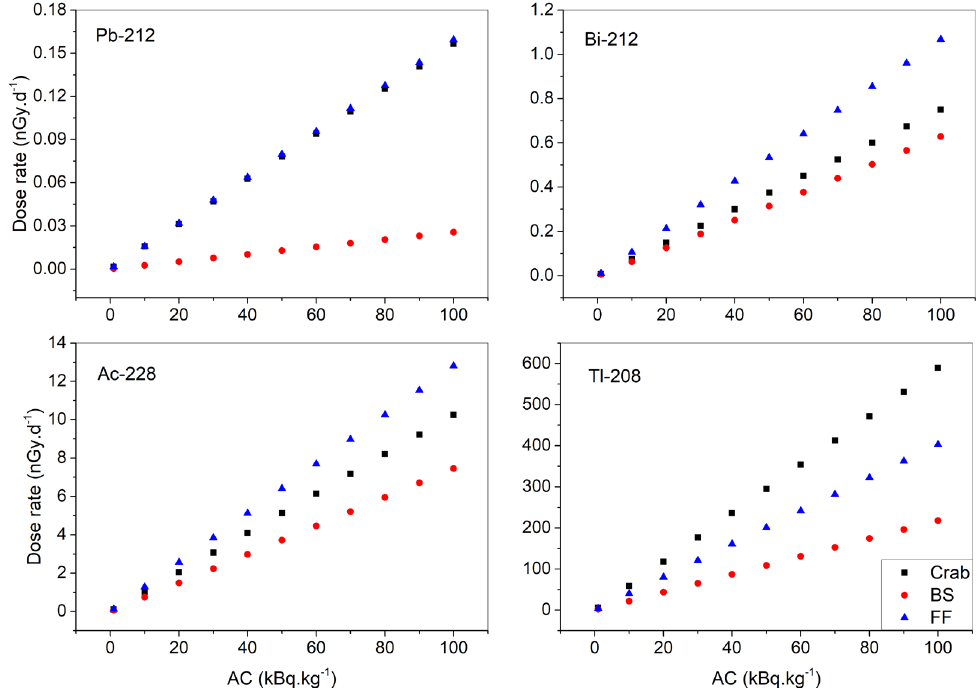
Figure 4. D ’s contribution due to the thorium series for each R